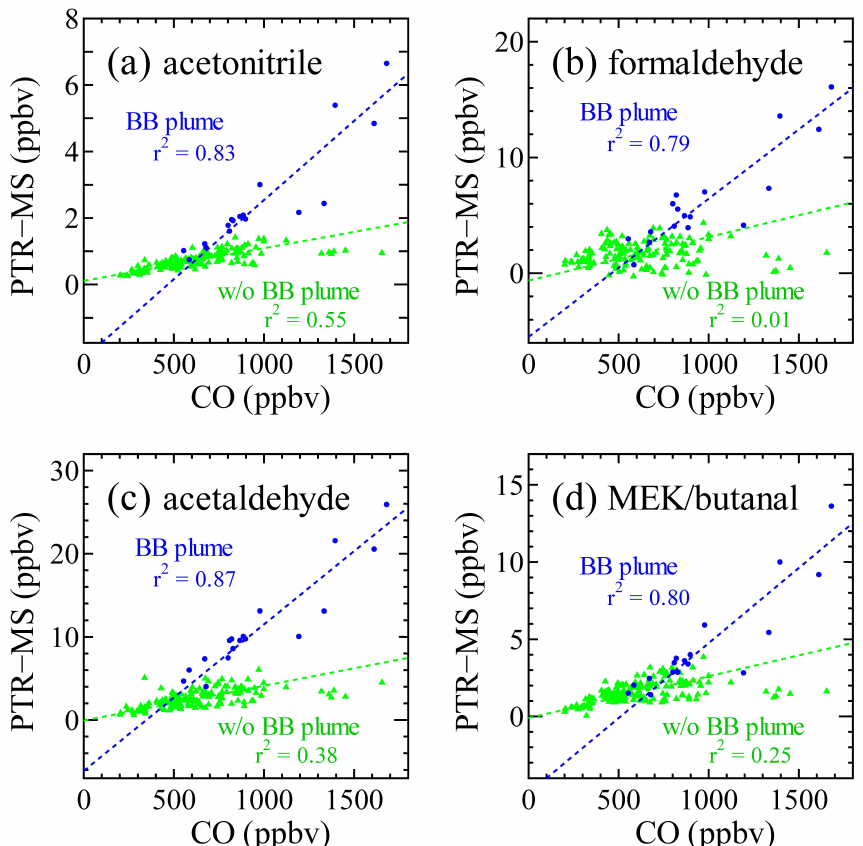
Fig. 9. Scatterplots of CO versus (a) acetonitrile, (b) formaldehyde, (c) acetaldehyde, and (d) MEK/butanal in the biomass burning plume (blue dots, n =17) and without biomass burning plume (green triangles, n =161). The best-fit lines obtained by RMA regression are shown as dashed